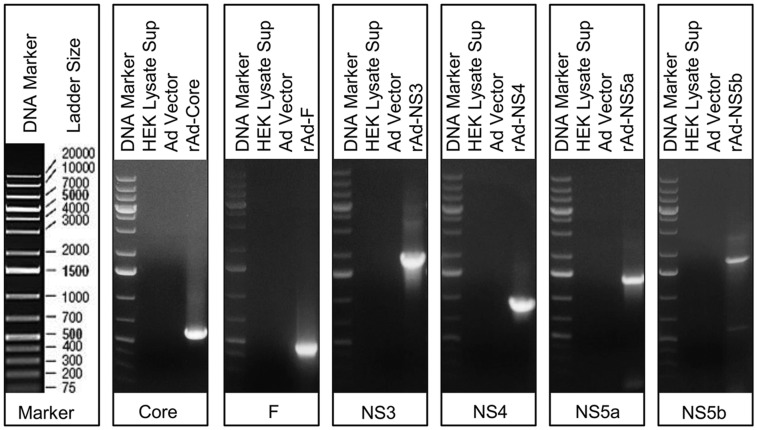
Characterization of Ad vector stock by PCR.HCV genes core, F, NS3, NS4, NS5a or NS5b are not amplified. First panel shows the DNA ladder, followed by agarose gel electrophoresis of PCR products obtained with HCV core, F, NS3, NS4, NS5a and NS5b specific primers. HEK lysate supernatant and rAd-HCV vectors were used as negative and positive controls. Data are representative of 2–3 repeated experiments.